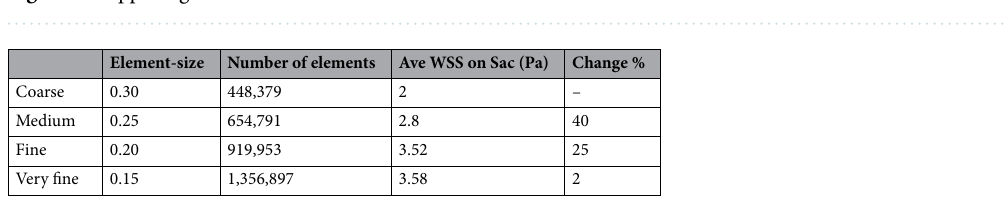
Figure 4. Applied grid for our model.